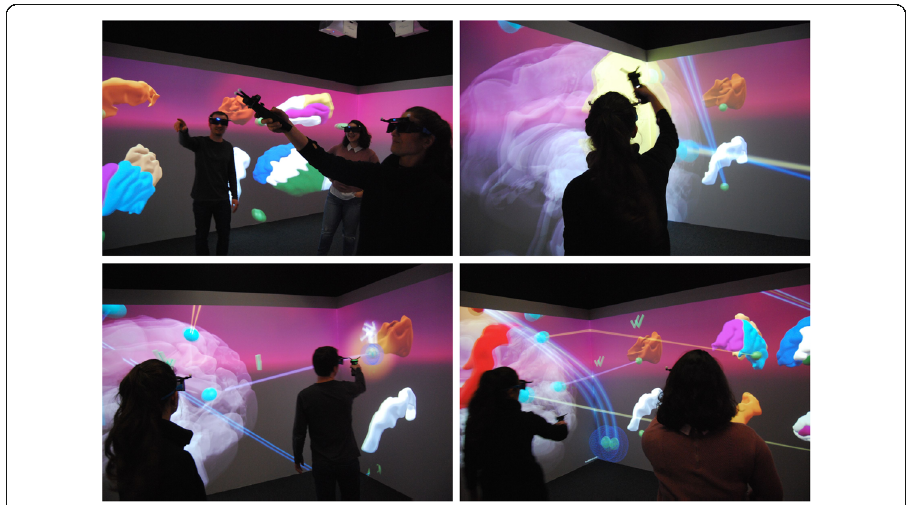
Fig. 4 Key game actions. Collaborative learning (top left), selecting brain parts (top right), drawing connections (bottom left), reviewing feedback (bottom